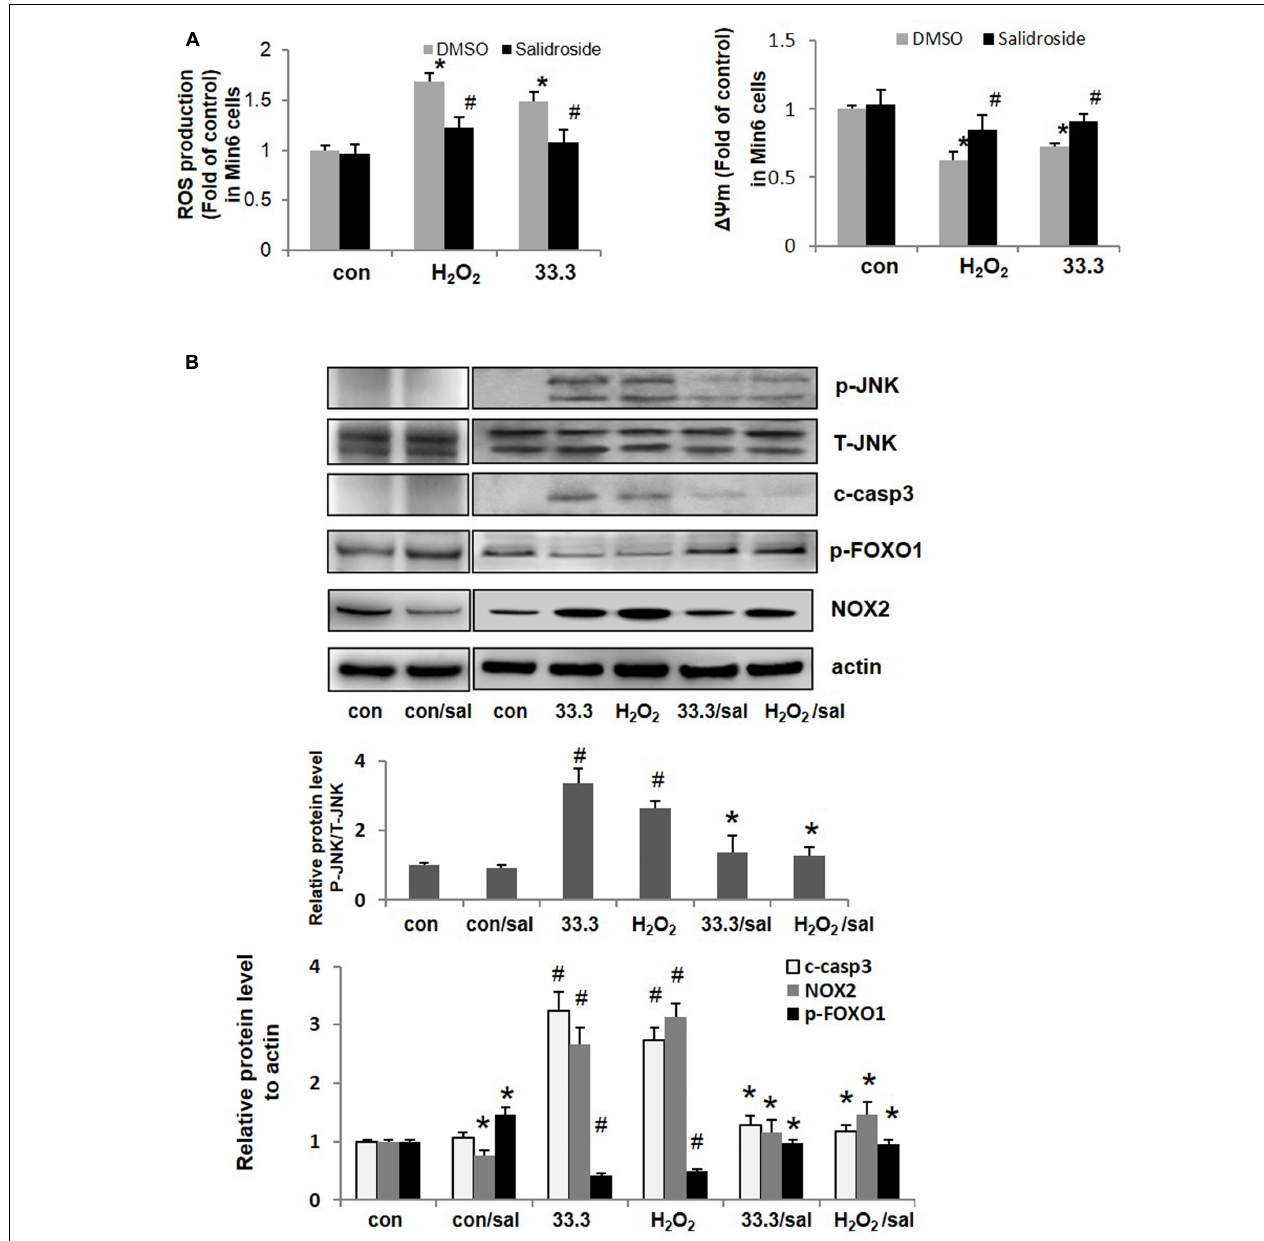
FIGURE 4 | Salidroside relieved oxidative stress and inhibited apoptotic cascade in β -cell. (A) ROS production and mitochondrial membrane potential ( (cid:49)(cid:57) m) were detected in Min6 cells ( ∗ p < 0.05 33.3 or H 2 O 2 to control, # p < 0.05 salidroside to DMSO). (B) Min6 cells were treated by 33.3 mM glucose or H 2 O 2 (200 µ M) with salidroside (50 µ M) or DMSO for 3 days. Representative western blots from islets with different treatments were